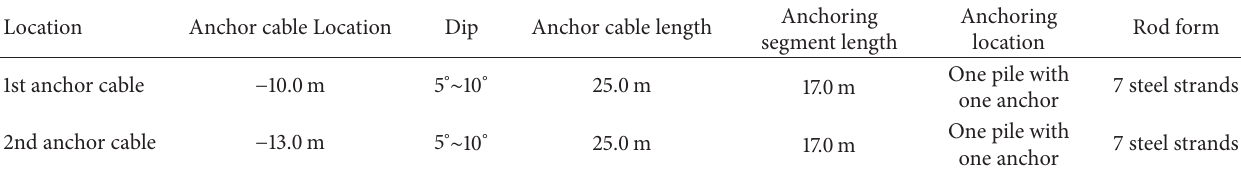
Table 3: Design parameters of anchor cables of northern support pile system.